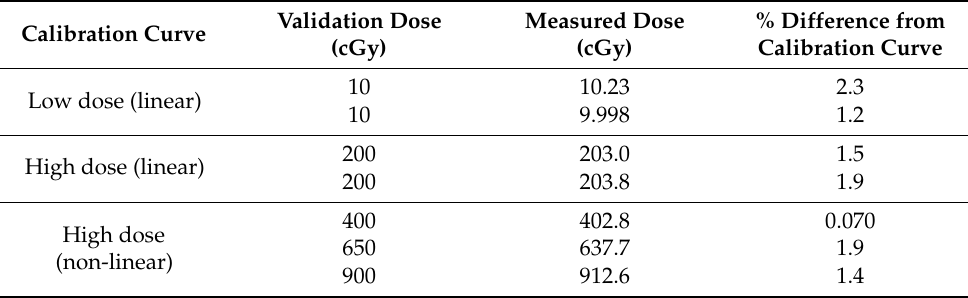
Figure 9. Calibration results. ( a ) Low dose linear calibration curve where d = 0.163 ± 0.003; ( b ) The overlay of the high dose linear and non-linear calibration curves where a = ( – 1.01 ± 1.06) × 10 −6 , b = 0.012 ± 0.001, c = −0.35 ± 0.36, and d = (9.6 ± 0.2) × 10 −3 . Table 2. Calibration validation. This table displays the calibration validation results for all three curves.